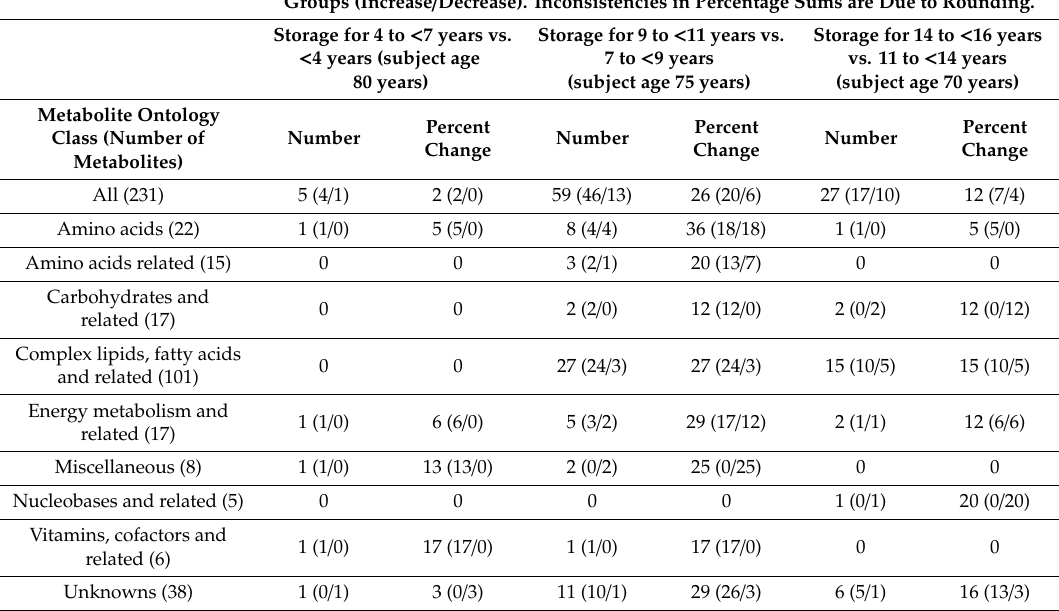
Table 1. Number of significant metabolite changes (ANOVA; p < 0.05 and FDR < 0.05) due to di ff erent sample storage times at − 80 ◦ C. Comparisons were made between storage times within subject age groups. Sample numbers per storage time group are: less than four years, n = 301; four to less than seven years, n = 300; seven to less than nine years, n = 425; nine to less than eleven years, n = 399; eleven to less than fourteen years, n = 460; and fourteen to less than sixteen years, n = 513. Significantly Changed Metabolites Long Storage vs. Shorter Storage within Subject Age Groups (Increase / Decrease). Inconsistencies in Percentage Sums are Due to